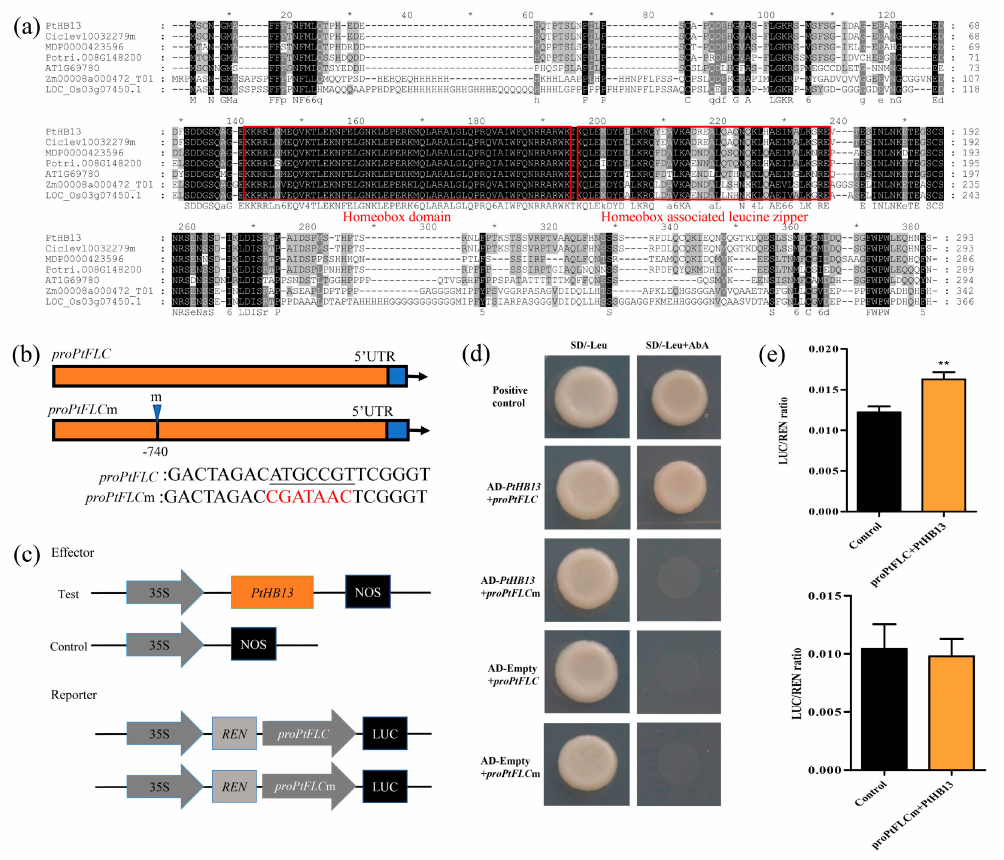
Figure3. PtHB13 directlybindstothepromoterof PtFLC .( a